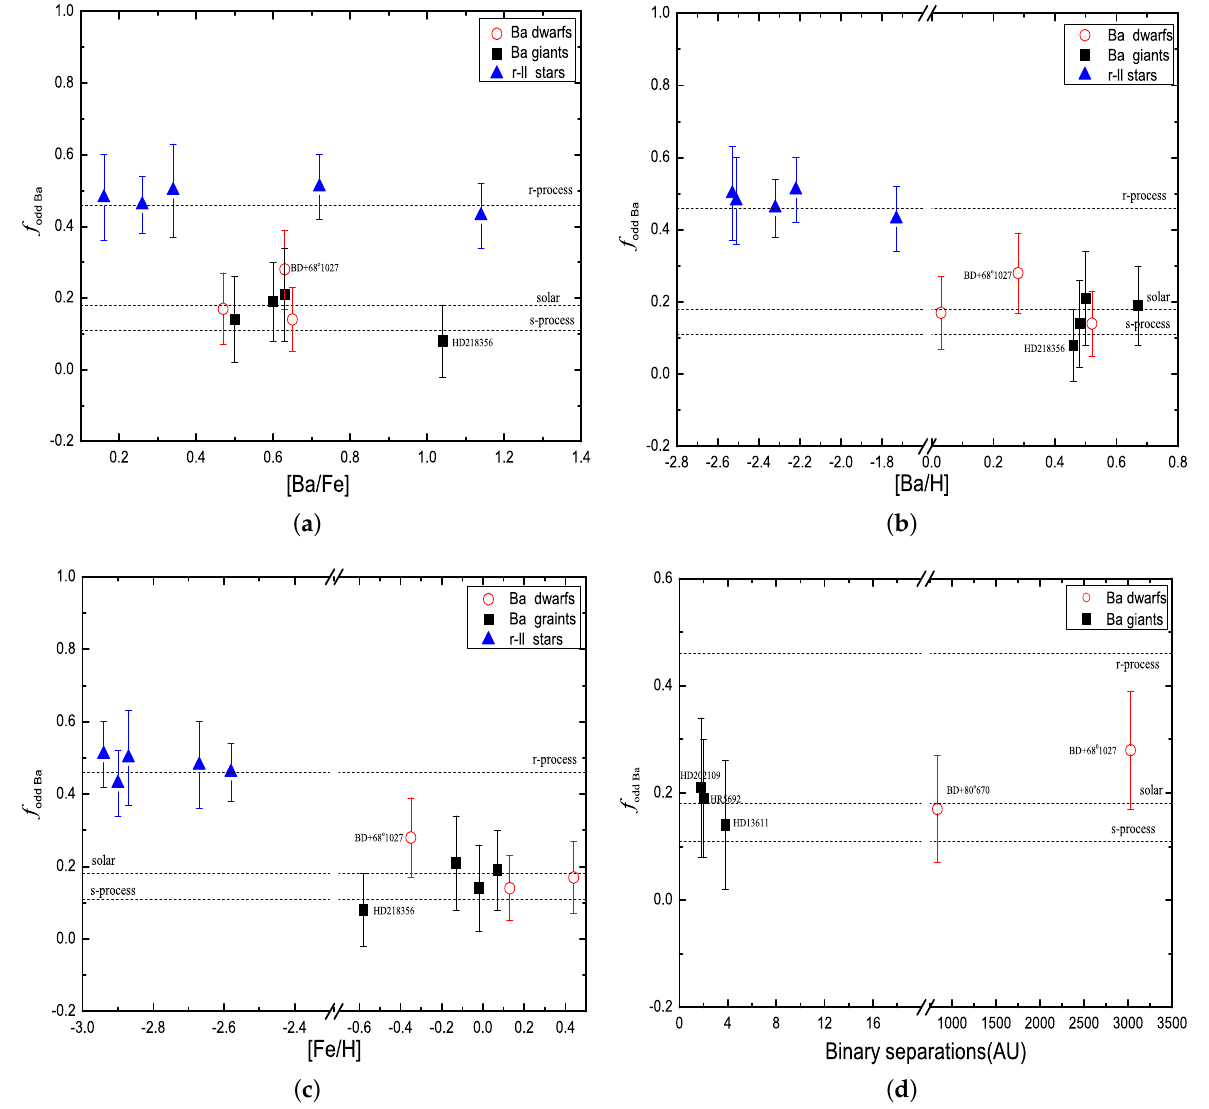
Figure 8. Fraction of the Ba odd isotopes versus [Ba/Fe] ( a ), [Ba/H] ( b ), [Fe/H] ( c ), and the or- bital separation of binaries ( d ). The r-II stars (filled triangle) derived by Meng et al. [34] and Wenyuan et al. [35] are also included for comparison. There are three dotted horizontal lines: the upper line ( f odd,Ba = 0.46) for the pure r-process, the middle line ( f odd,Ba = 0.18) for the solar sys- tem, and the following line ( f odd,Ba = 0.11) for the pure s-process of the solar barium predicted by Arlandini et al.